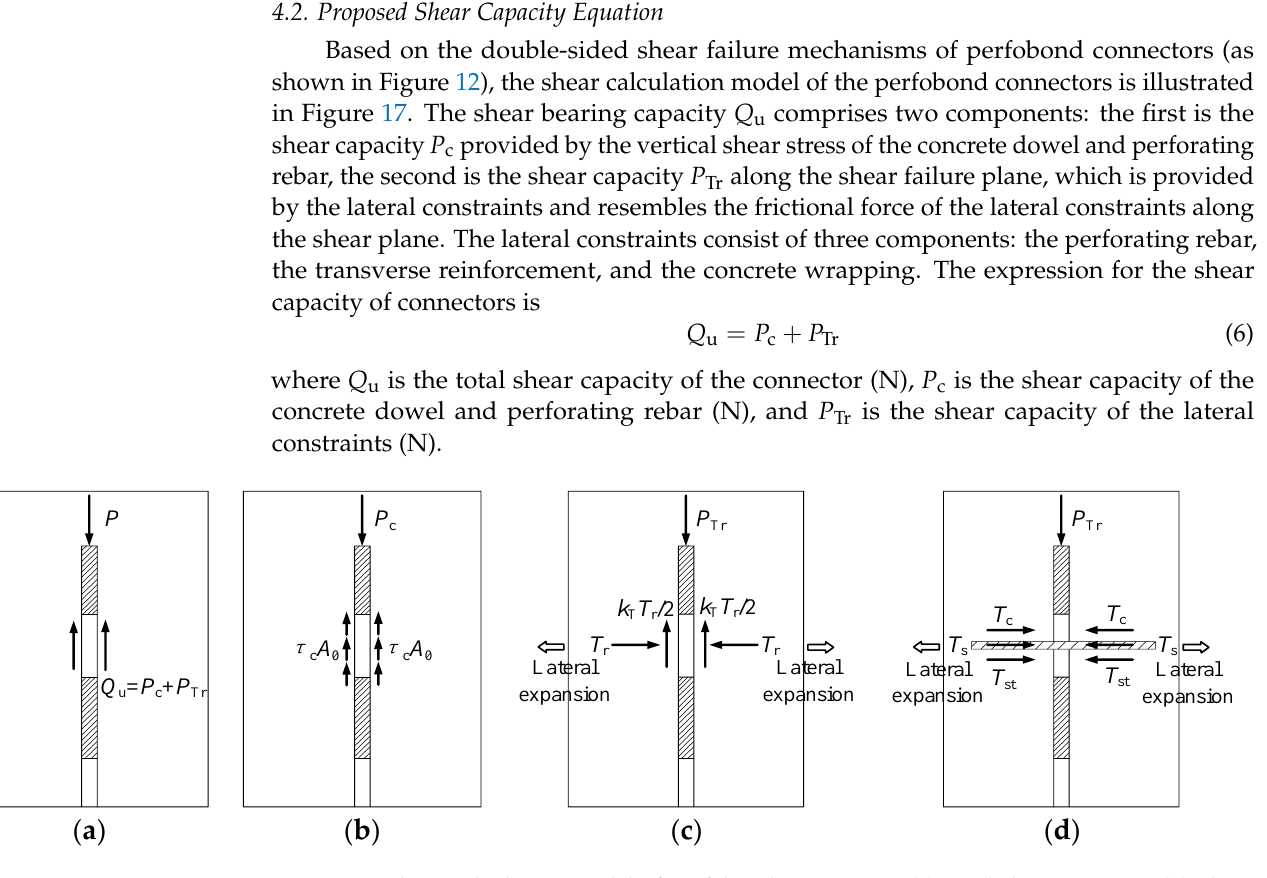
Figure 17. Shear calculation model of perfobond connectors: ( a ) Total shear capacity; ( b ) Shear contribution of concrete dowel and perforating rebar; ( c ) Shear contribution of lateral constraints; ( d ) Composition of lateral constraints.